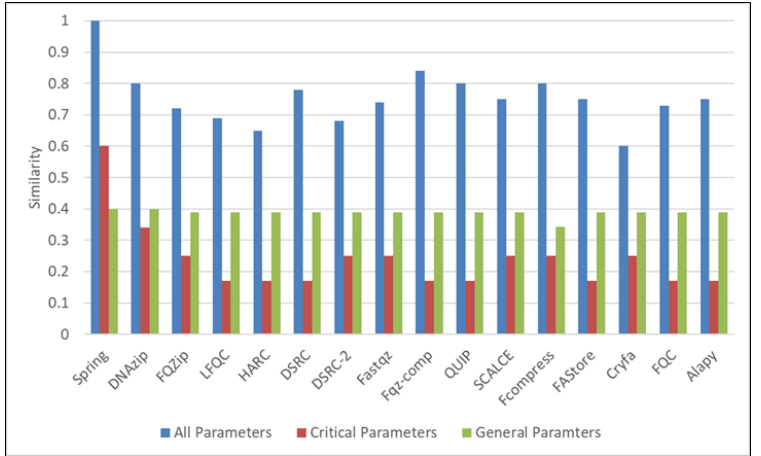
Figure 6. Similarity and weighting results of NGS non-referential